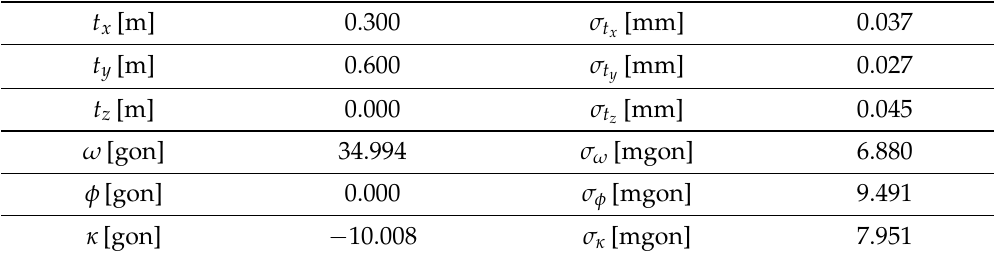
Table 6. Results of the estimated rigid body movement after having extended S CS (data set V15, a = 1, n CS , val = 14, n CS , ex = 28) [30].